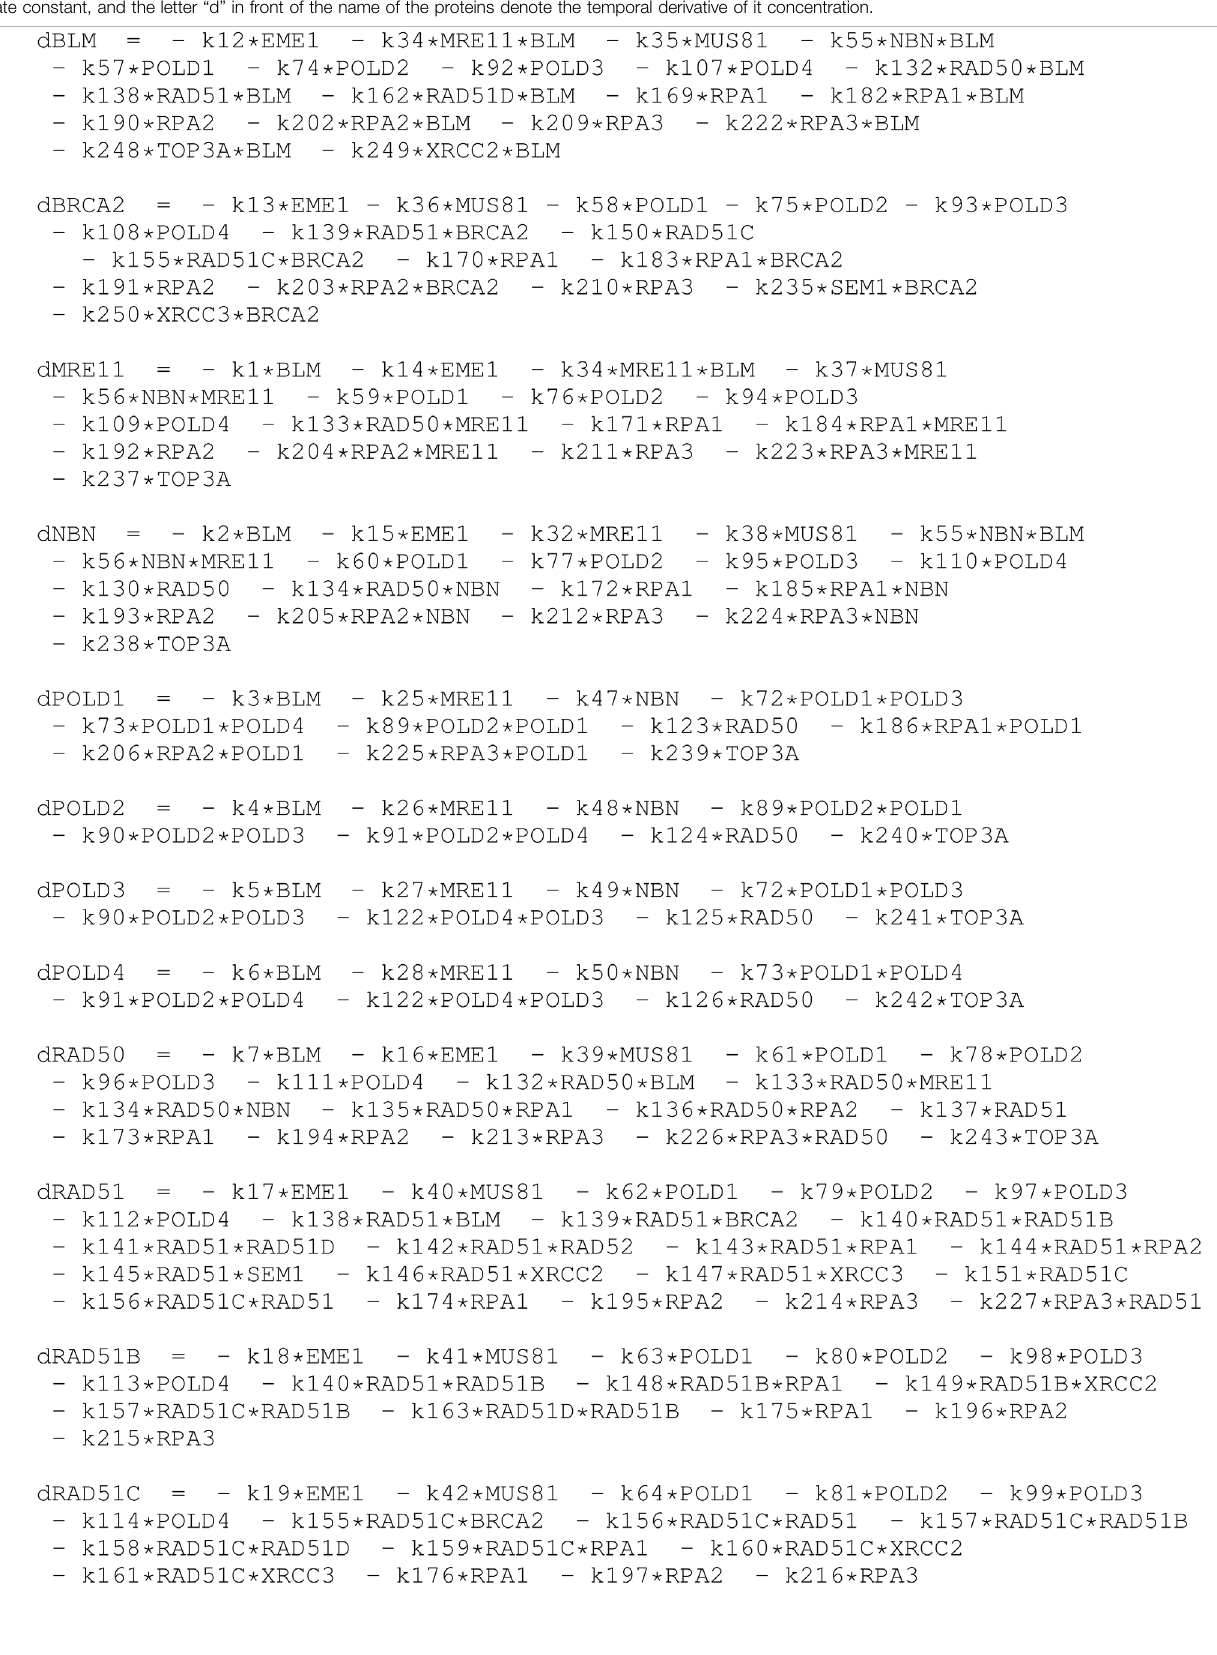
Frontiers in Molecular Biosciences |